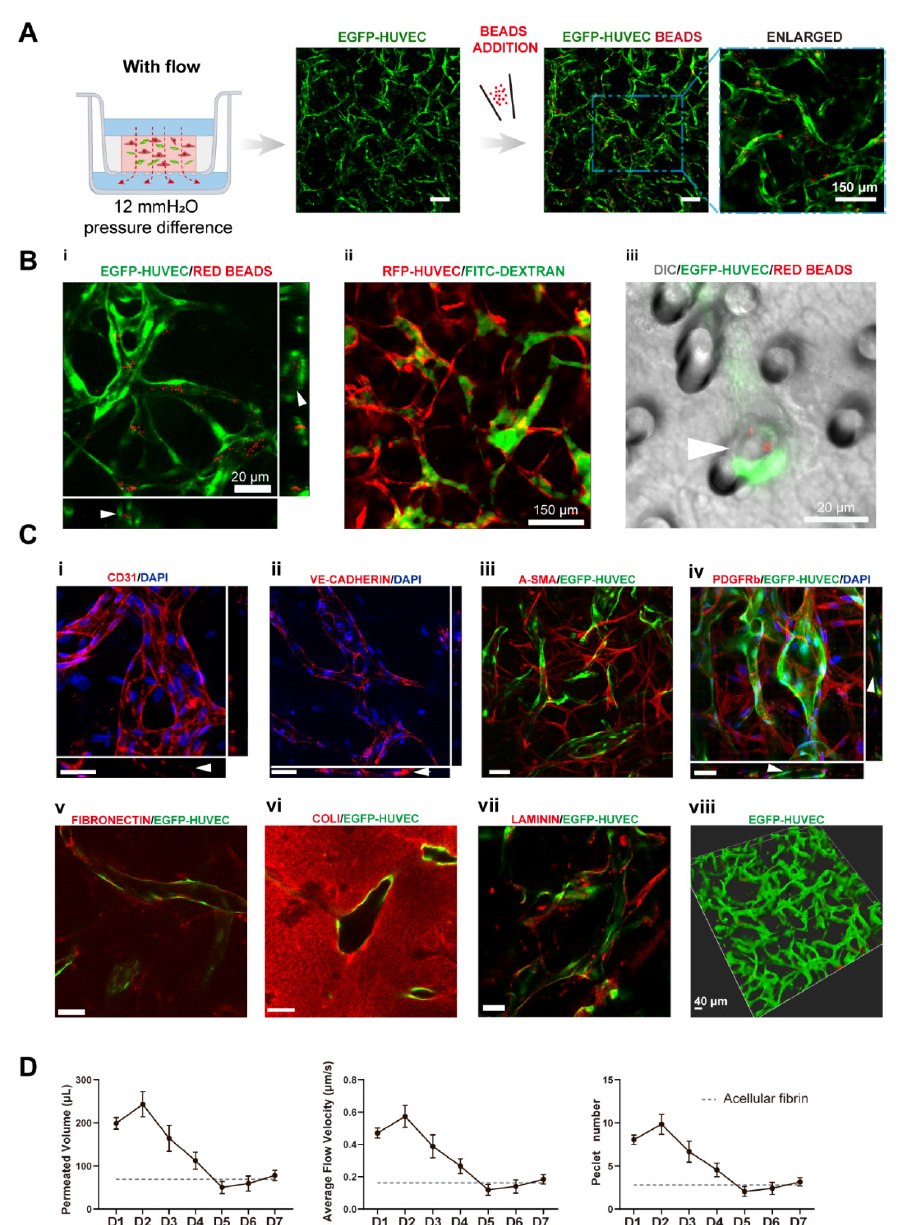
Figure 2. Transwell ‐ based vascularized model establishment and characterizations. ( A ) Confocal images of constructed vasculatures in the presence of interstitial flow and NHLFs. The constructed vessels were perfused with red beads to characterize the perfusability. Scale bar: 150 µ m. ( B ) Validations of the lumenization and perfusability of the vascular network. ( i ) Projected images of beads perfused vessels, and white arrows are pointing at constructed lumens where red beads were located. ( ii ) FITC-dextran was well perfused in the blood vessels without noticeable leakages. ( iii ) EGFP-HUVECs sprouted across the porous membrane, with beads flowing through the vessel, indicated by the white arrow. Scale bars are indicated in the pictures. ( C ) Immunofluorescent images of cell adhesion molecule: CD31 ( i ), intercellular junctions: VE-cadherin ( ii ), NHLF: a-SMA and PDGFRb ( iii , iv ), deposited extracellular matrix: fibronectin ( v ), collagen I ( vi ), and laminin ( vii ). The 3D rendering image of reconstructed vasculatures ( viii ). Scale bar: 40 µ m. ( D ) The permeated volume, average flow velocity, and P é clet number statistics in the presence of NHLFs over 7 days period with the gray dash line indicating the acellular fibrin. The data was presented with the average value ± standard deviation ( n =